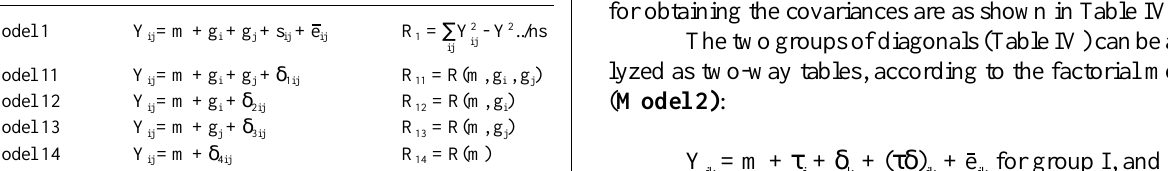
Table II - Representation of the complete and reduced models and their sums of squares. Sums of squares